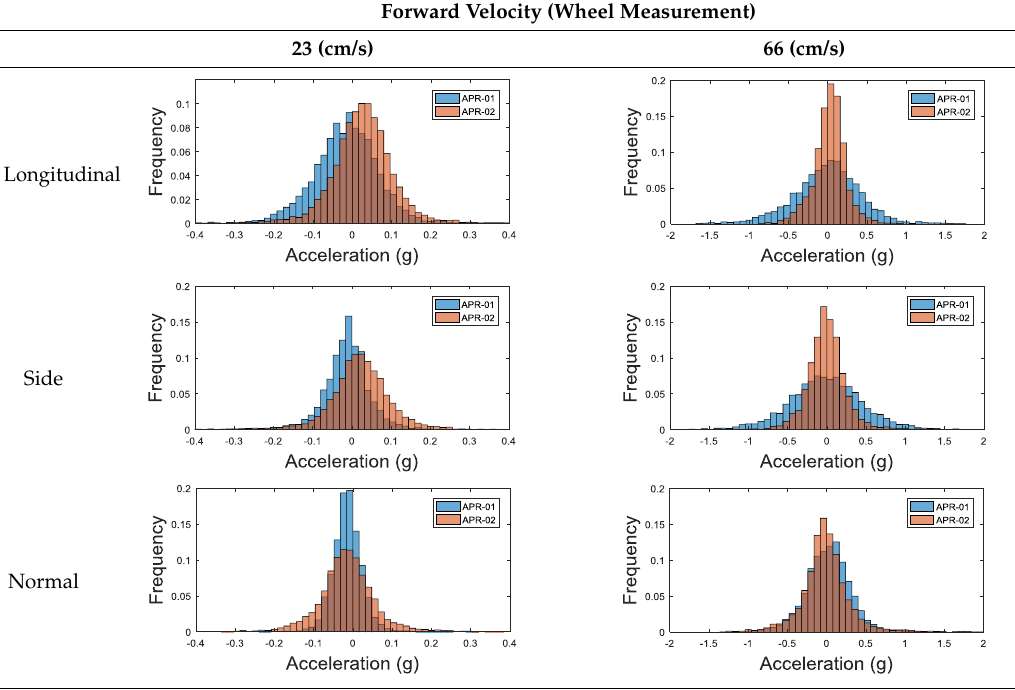
Table 6. Vibration pattern histograms measured in the wheel of the two APR prototypes.